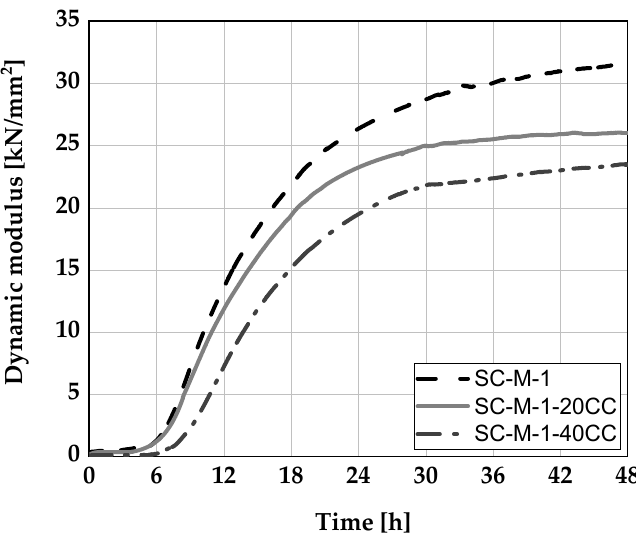
Figure 9. Dynamic modulus of elasticity of SC-M specimens.